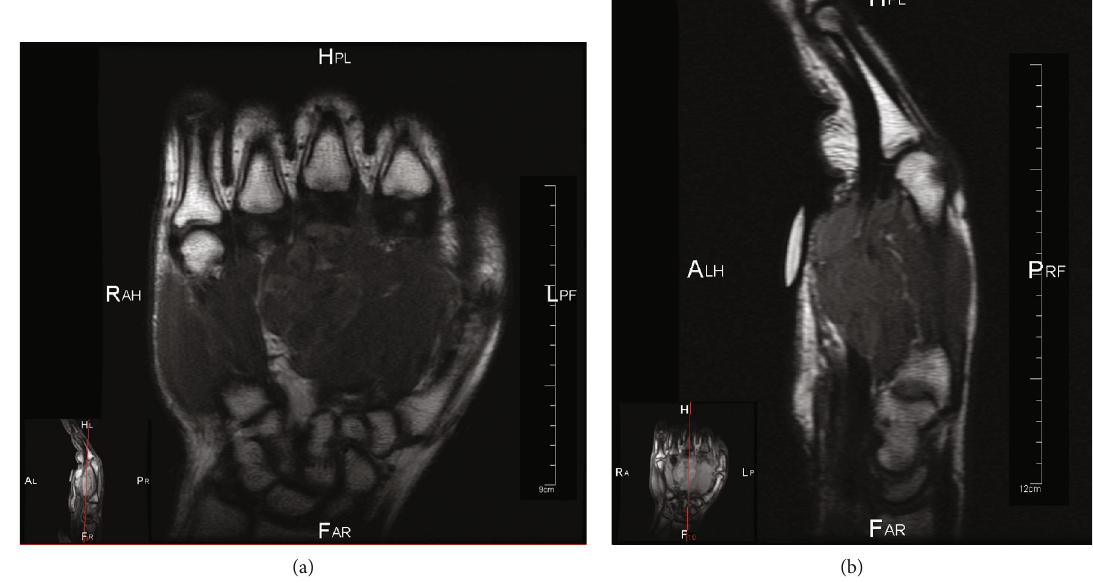
Figure 1: T1-weighted coronal and sagittal MRI revealing a large, lobulated, soft tissue lesion with aggressive features located on the ventral surface of the hand and extending from the mid-third digit to the fi fth digit. (a) Coronal view demonstrating a hypointense enhancing lobular lesion at the third ray. (b) Sagittal view showing a soft tissue lesion surrounding the fl exor tendons and extending into the interspace between the head of the third and fourth